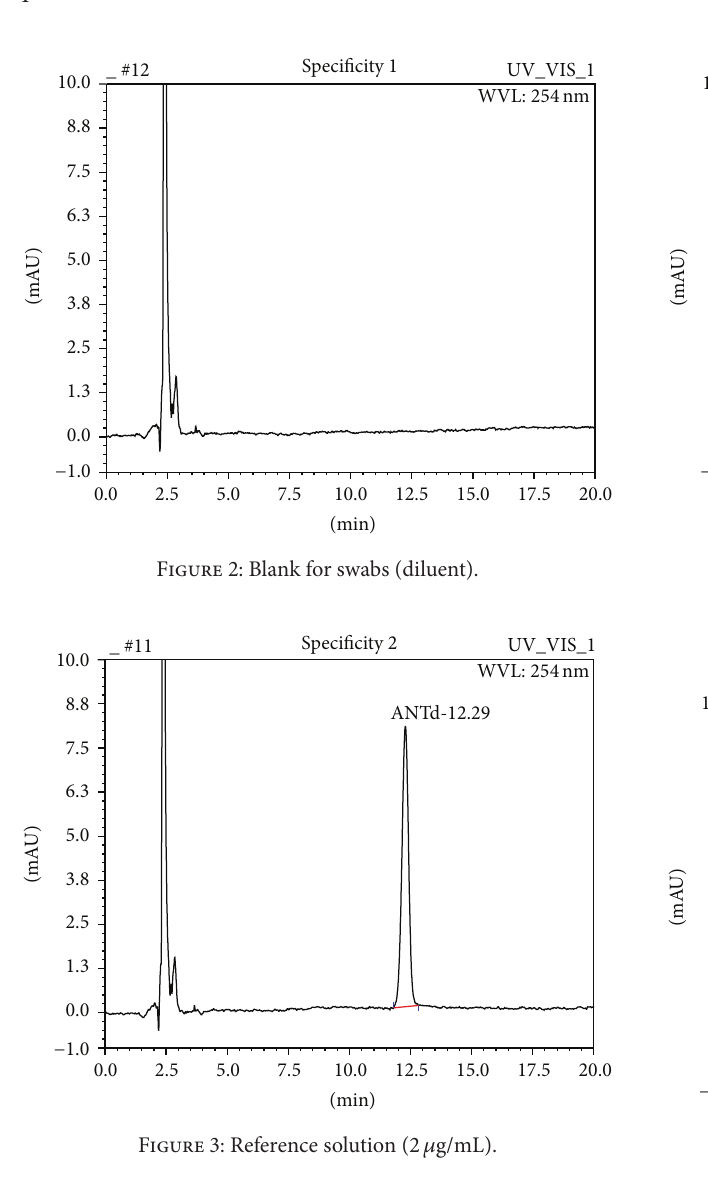
Figure 5: Swabs of pure stainless-steel